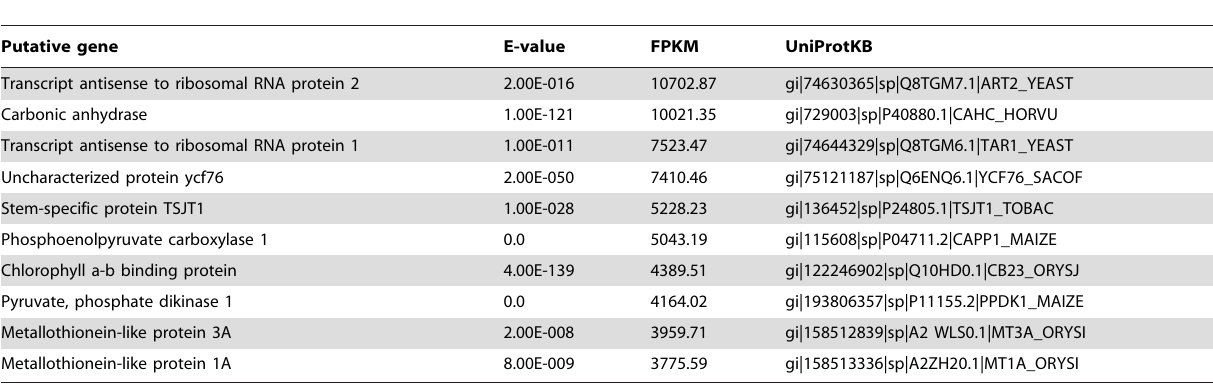
Table 3. The 10 most abundant transcripts found in the Guinea grass leaf